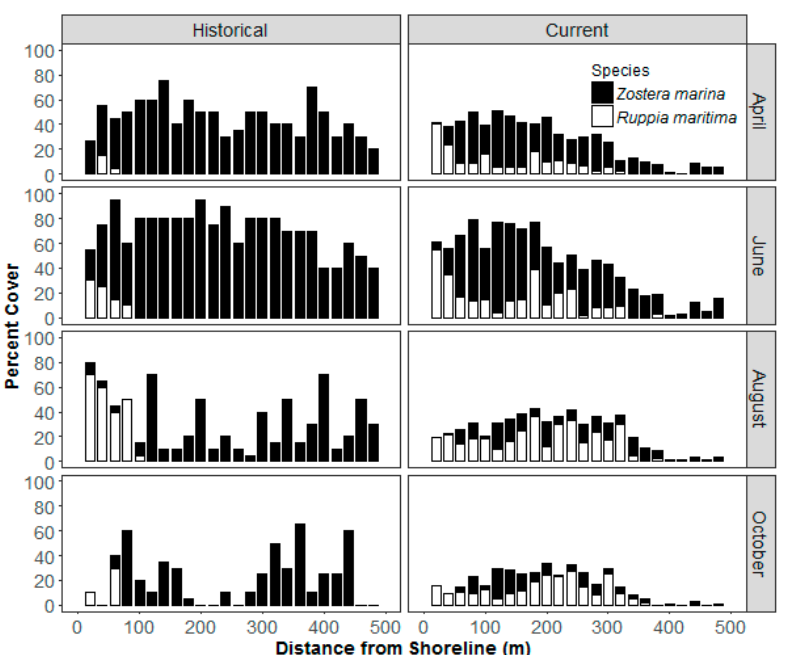
Figure 4. Mean percent cover for Z. marina (black) and R. maritima (white) along the GI-3 transect. Historical data on the left are adapted from those of a previous publication in Journal of Coastal Research [29], sampled from 1994–1995 at the same transect. The right plot is mean percent cover from 2010–2017. Each row is a different month (April, June, August, October).